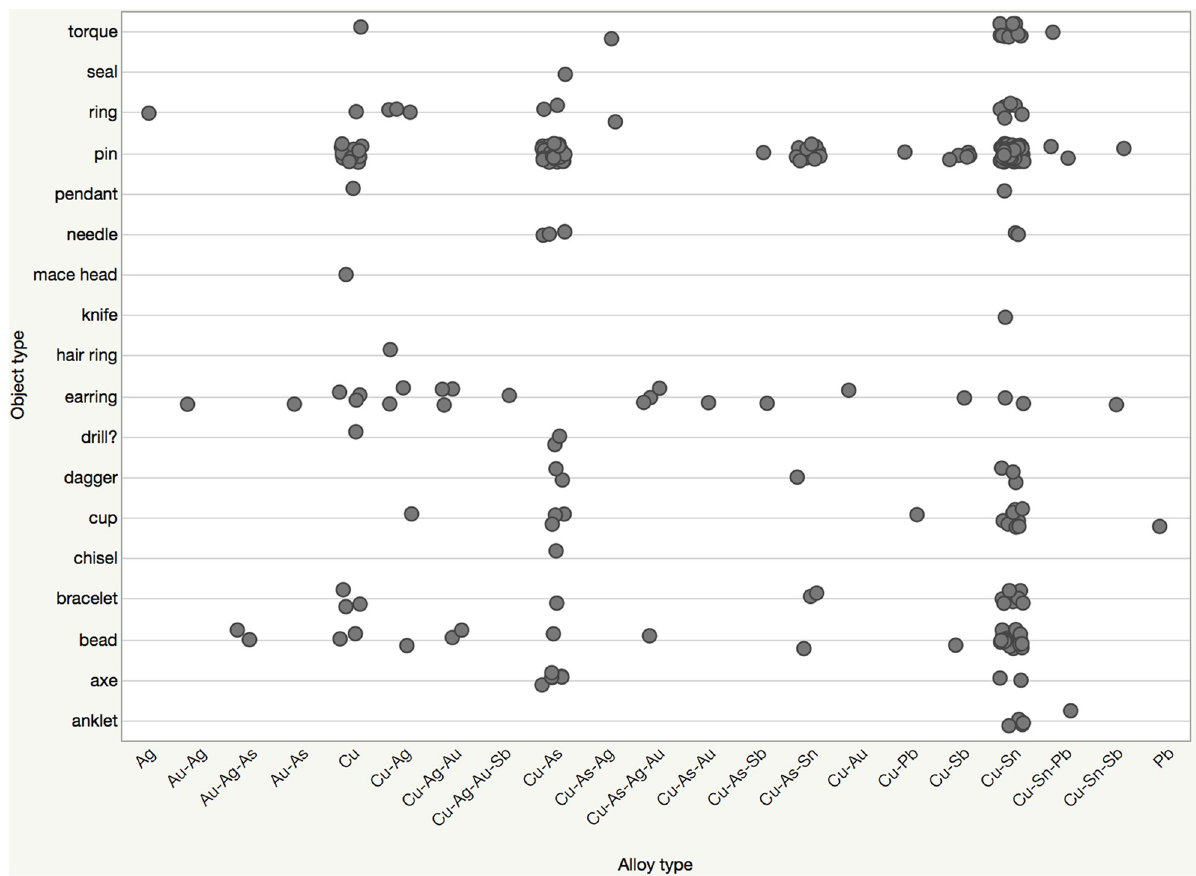
Fig 9. Object type versus alloy type among the Resulo ğ lu metal